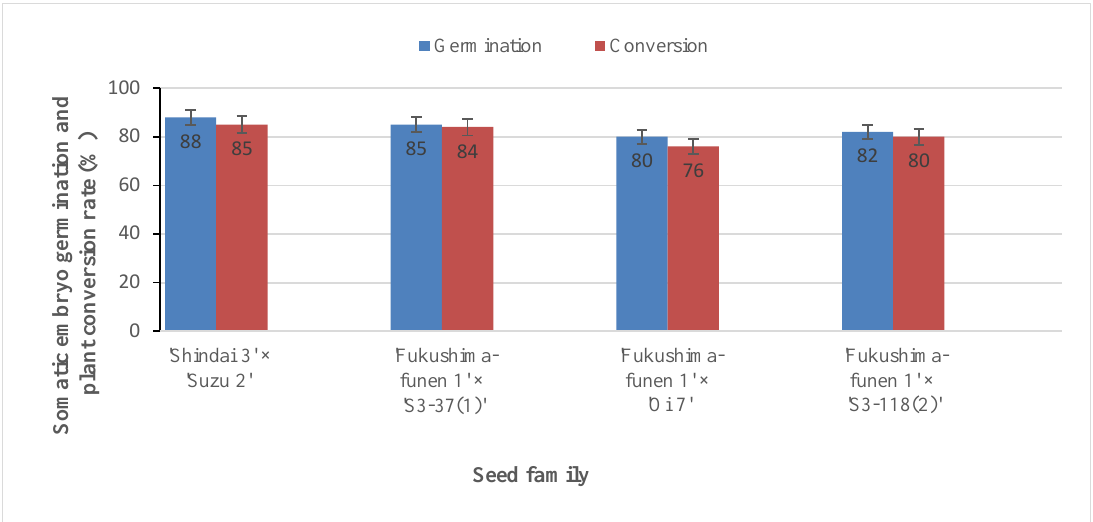
Figure 5. Regeneration and in vitro growth of somatic plants originating from embryogenic cells of different seed families, ( A – D ) somatic embryo germination, ( E – H ) plants growing in vitro before acclimatization. ( A , E ) line from ‘Shindai 3’×’Suzu 2’ family, ( B , F ) line from ‘Fukushima-funen 1’×’S3-37(1)’ family, ( C , G ) line from ‘Fukushima-funen 1’×’Oi 7’ family, ( D – H ) line from ‘Fukushima-funen 1’×’S3-118(2)’ family. Bars ( A – D ) 1 cm, ( E – H ) 5 cm.